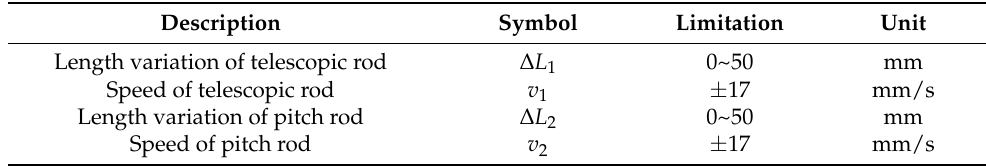
Table 3. Limitations of the gangway